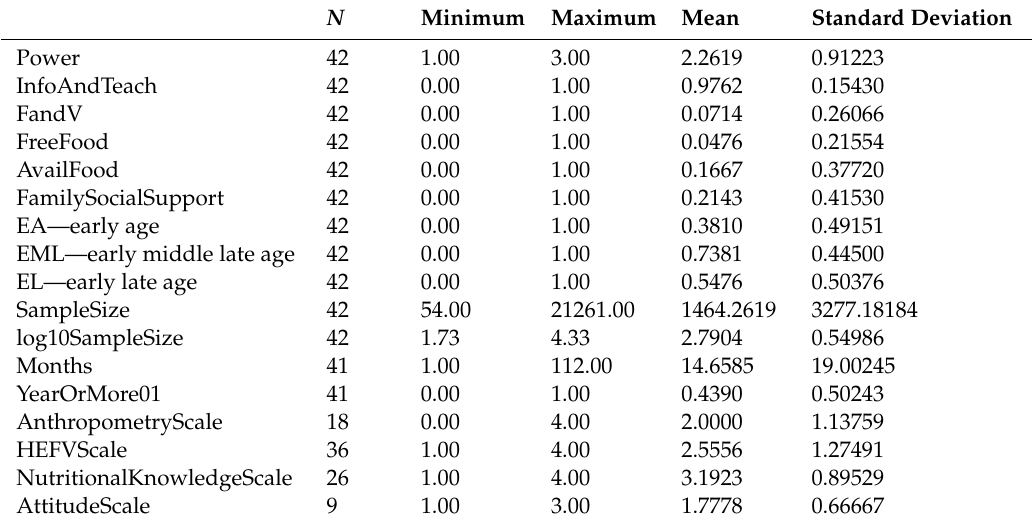
Table 4. Descriptive statistics.